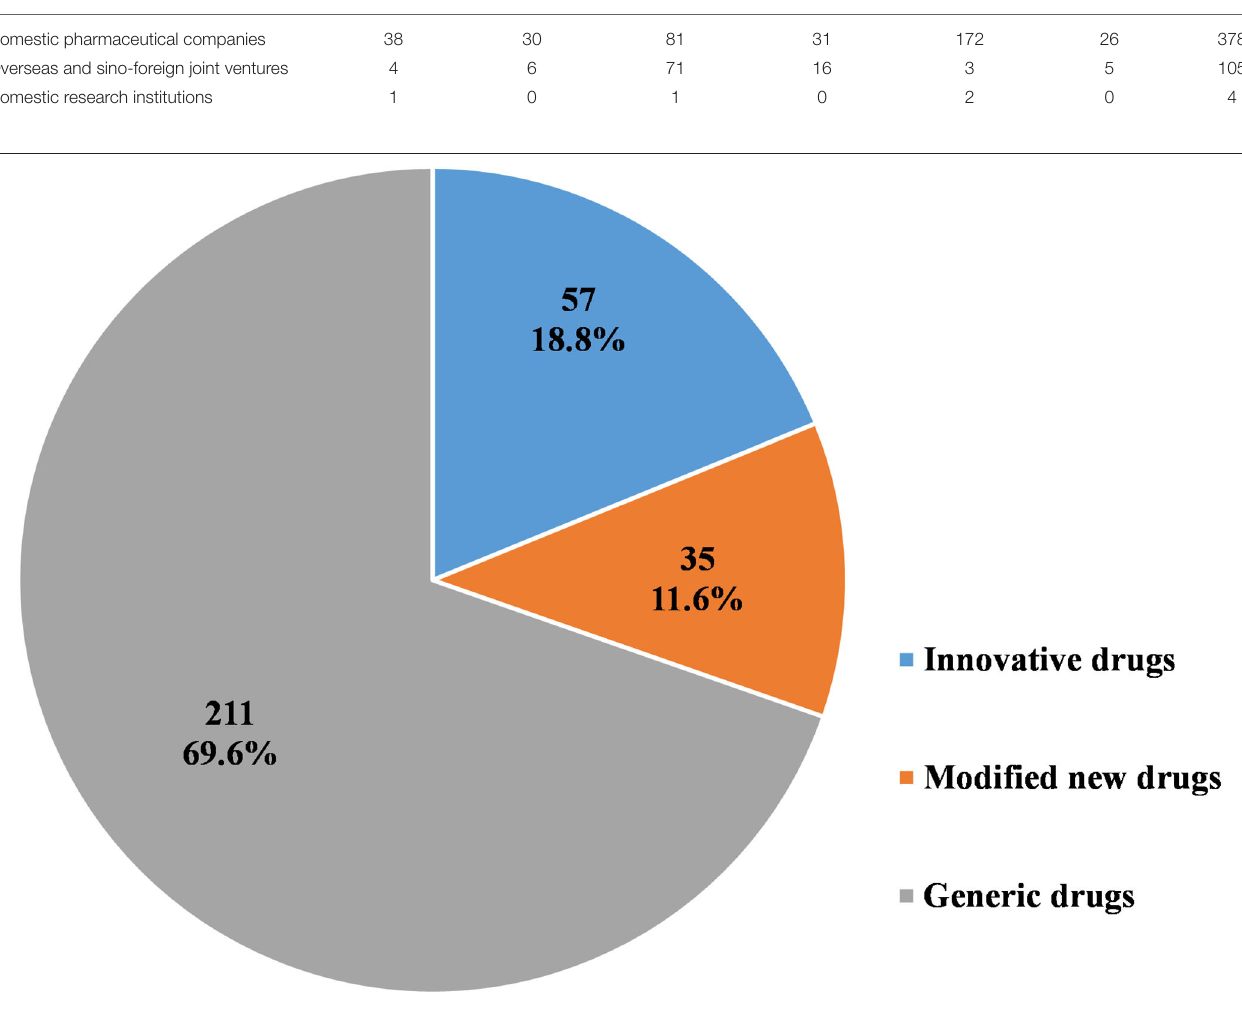
FIGURE 6 | Distribution of chemical drugs by registration classification in pediatric clinical